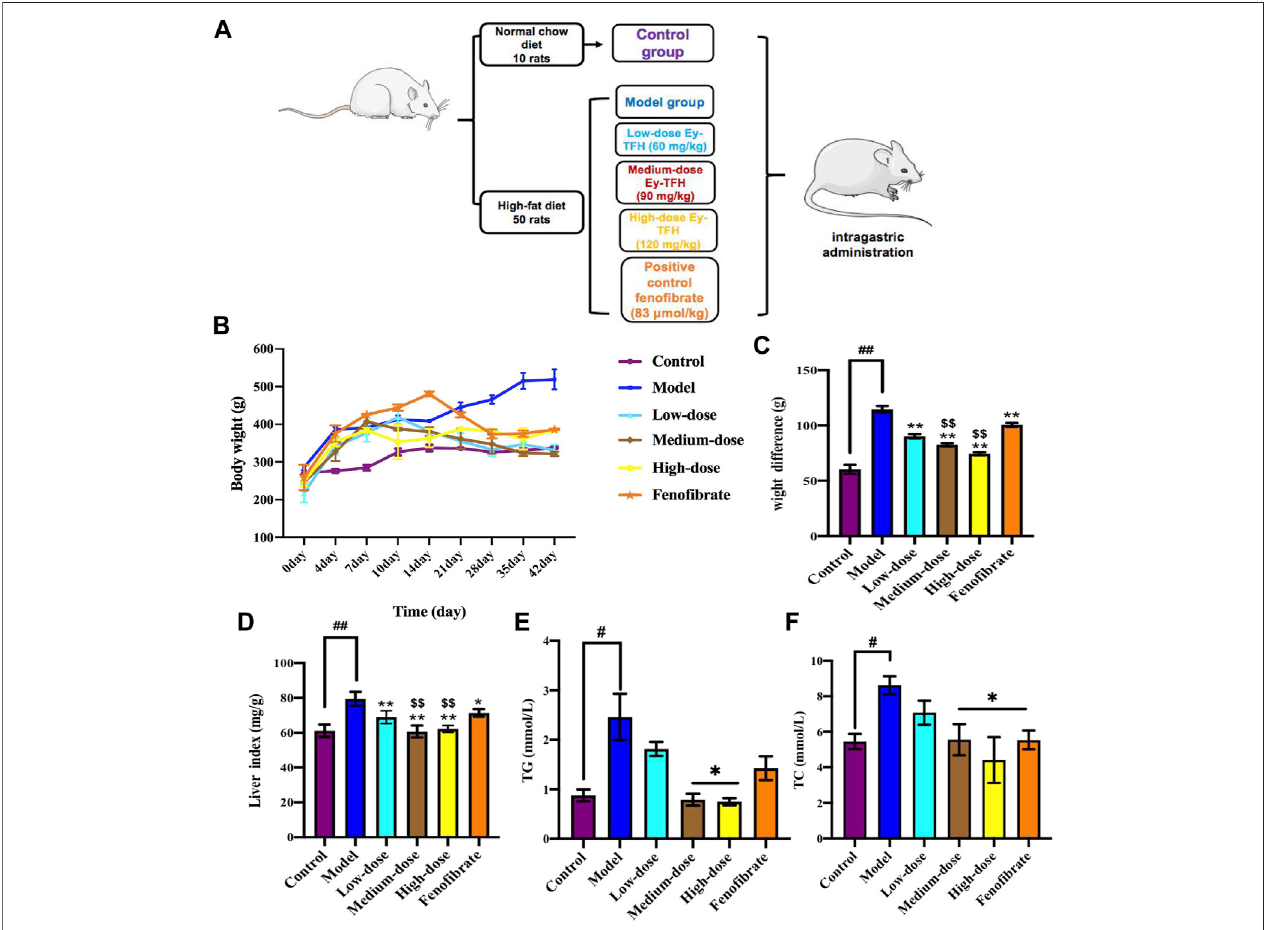
FIGURE 5 | Effect of Ey-TFH on lipid accumulation. (A) The scheme of HFD - induced NAFLD model and Ey-TFH treatment. (B) Growth curve. (C) Weight difference. (D) Liver index. (E) TG contents. (F) TC contents. # p < 0.05, compared with the control group; * p < 0.05, compared with the model group; $$ p < 0.01, compared with the position control